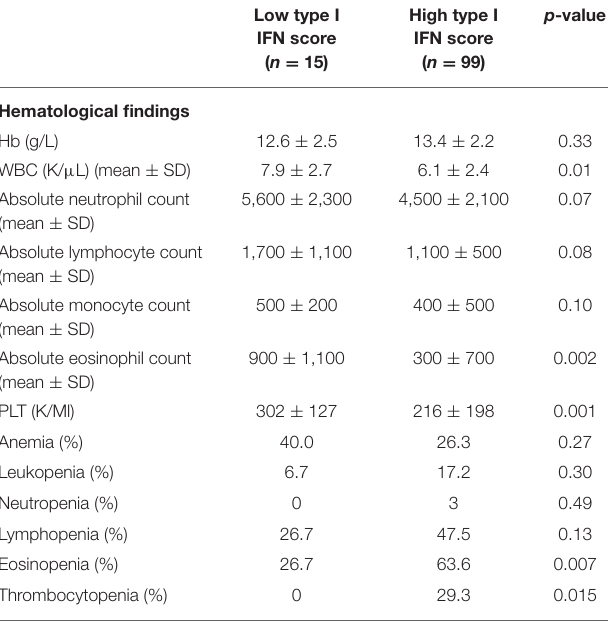
TABLE 4 | Hematological variables in low and high type I IFN score